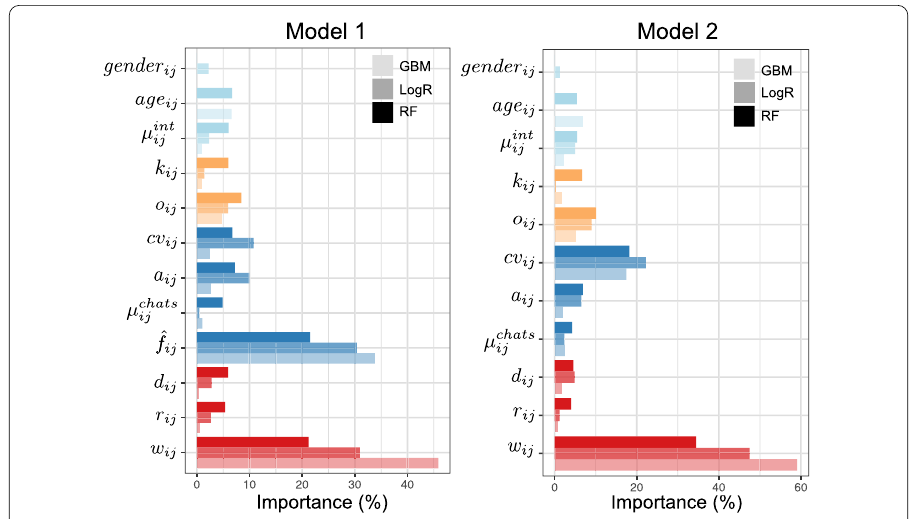
Figure 4 Comparison with other algorithms. Comparison of the importance of the variables for the two models using different algorithms, namely Random Forests (RF), Logistic Regression (LogR) and Generalized Boosted Regression Models (GBM). As we can see models agree on the relative importance of individual and group variables. Color of the variables correspond to the intimacy (light blue), structural (orange), temporal (blue) and intensity (red)